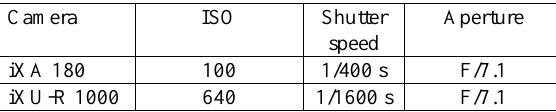
Figure 6. Exposure parameters in